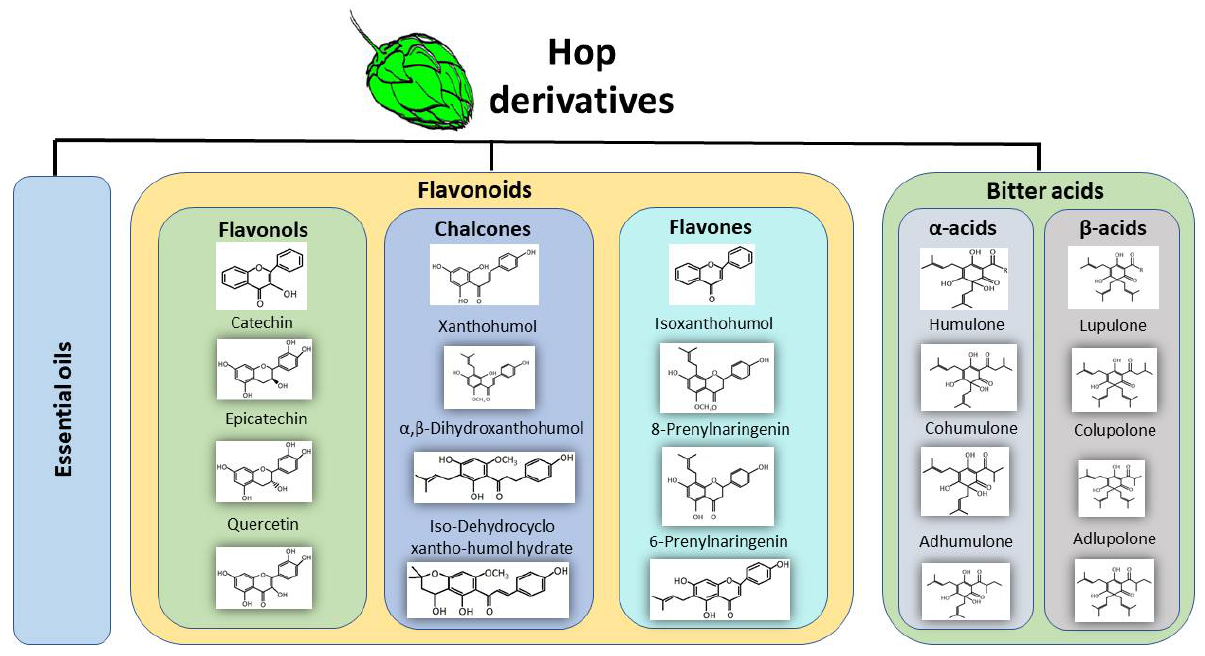
Figure 1. The main derived compounds from hop cones. Hop cones are the main source of bioactive compounds during the brewing process. Hops contribute essential oils, phenolic compounds such as flavonoids which can be further classified into flavonols, chalcones, and flavones. Hop cones contain α -acids and β -acids also known as bitter